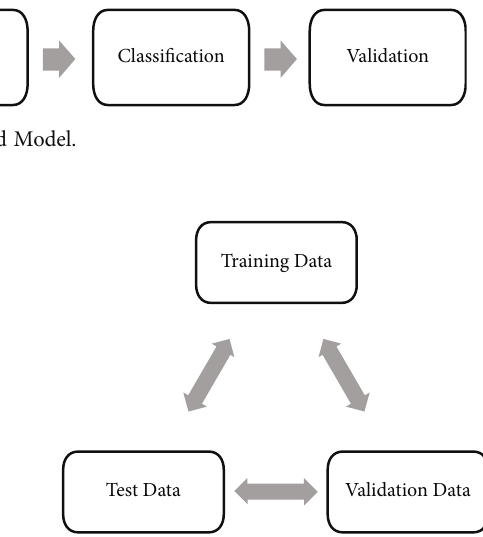
Figure 2: Subsets of the model selection